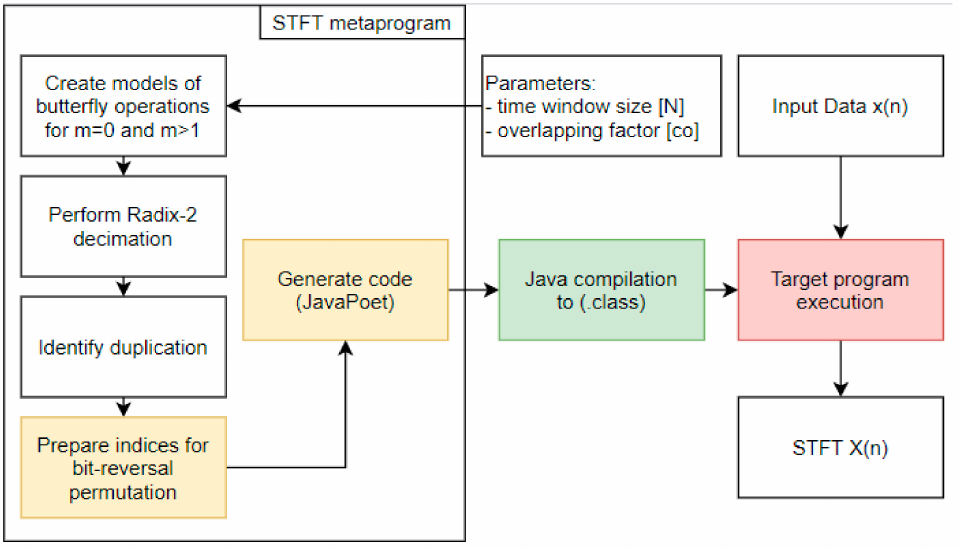
Figure 4. Short-time Fourier Transform with metaprogramming technique block diagram; metapro- gram on the left; STFT runtime phase on the right side. Solution without Stockham